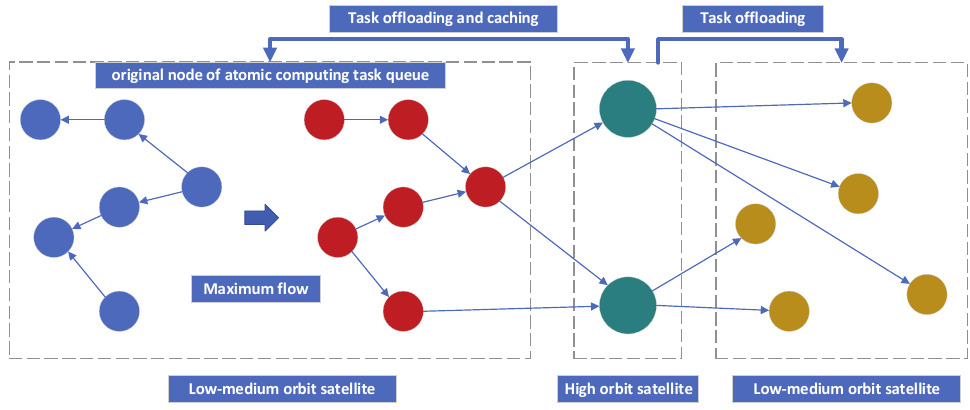
Figure 3. Mission offloading of low-medium orbit satellites and re-offloading process of high- orbit